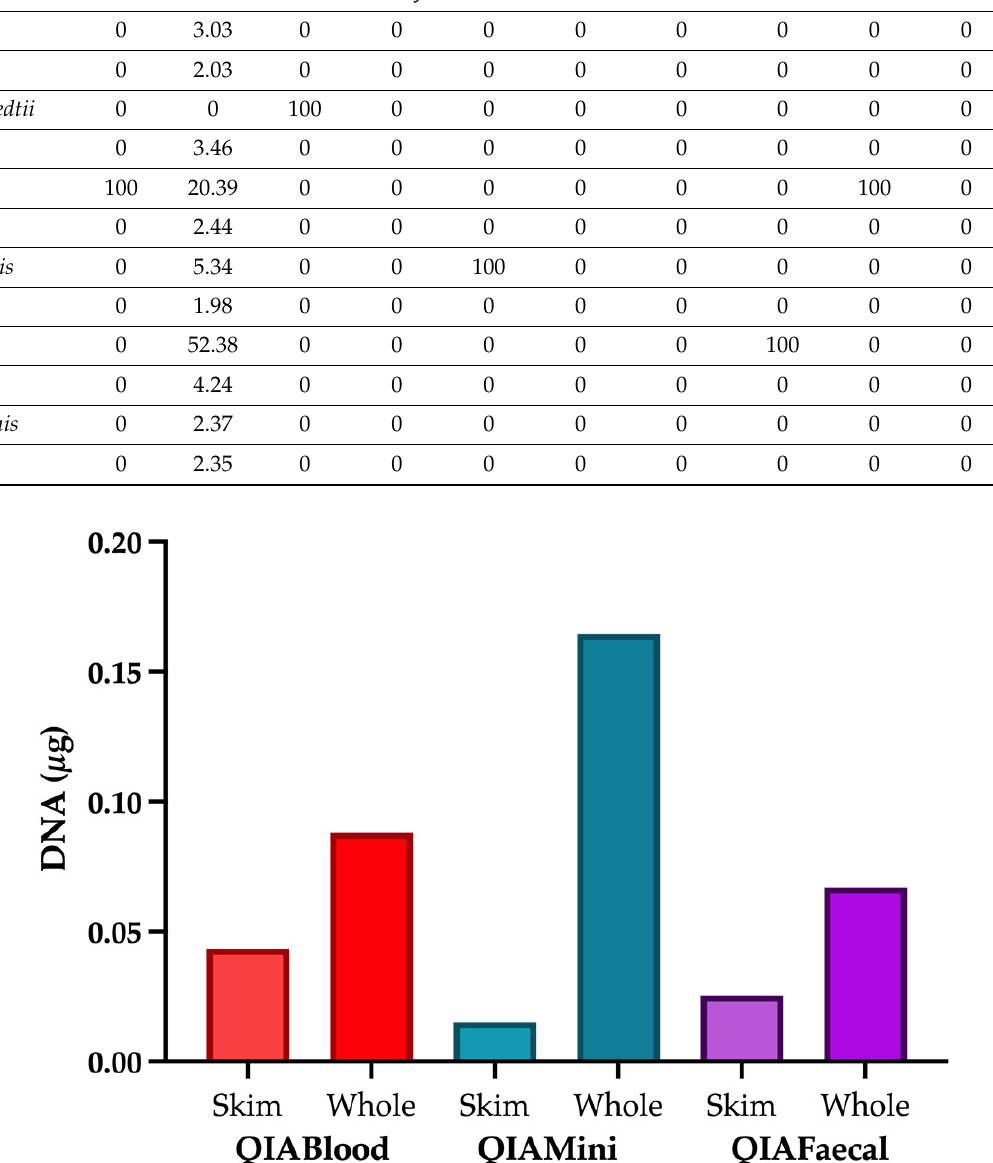
Figure 1. Comparison of total DNA extracted in a single elution of different extraction kits of both whole and skim milk. QIABlood is the QIAamp DNA blood mini kit, QIAMini is the QIAamp DNA mini kit, and QIAFaecal of QIAamp DNA PowerFaecal Pro DNA kit. Extraction controls were all undetectable at less than <0.5 ng/mL.